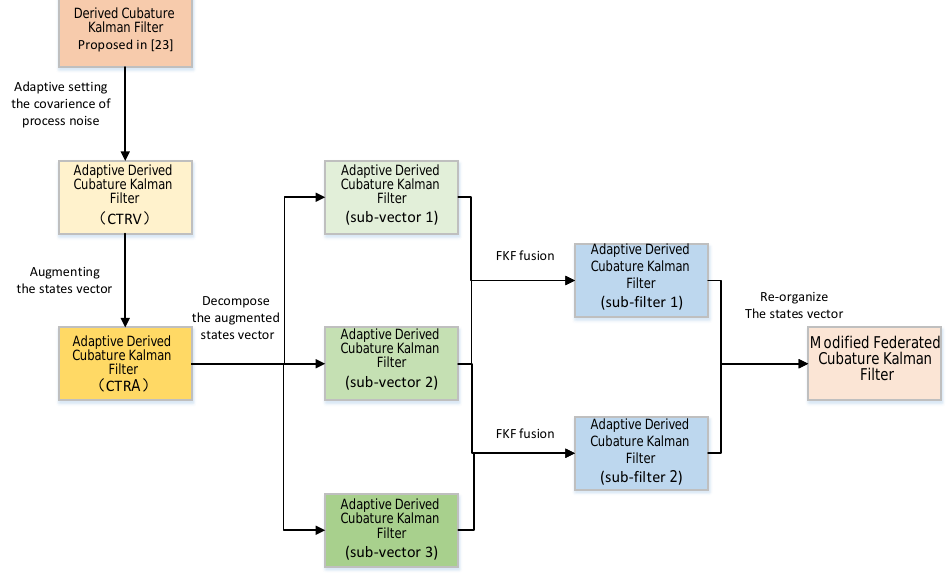
Figure 1. The overall structure of the